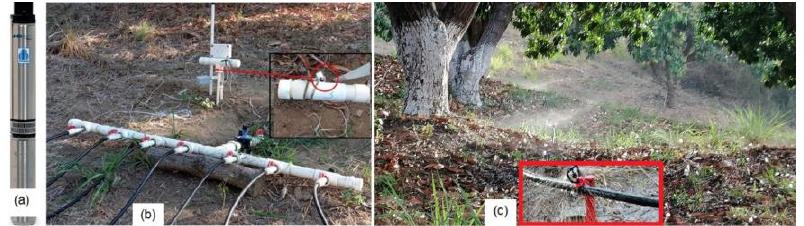
Figure 3. Irrigation system including ( a ) pump, ( b ) solenoid valve with connection to lateral hoses, and ( c ) micro sprinklers.